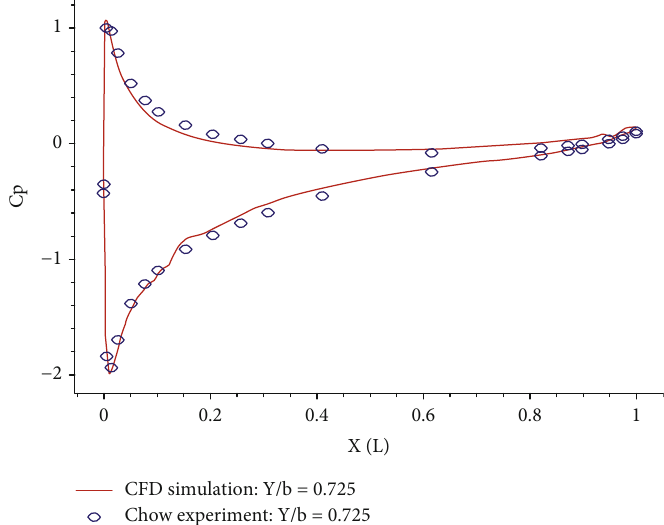
Figure 3: The pressure coe ffi cient distribution at 72.5%